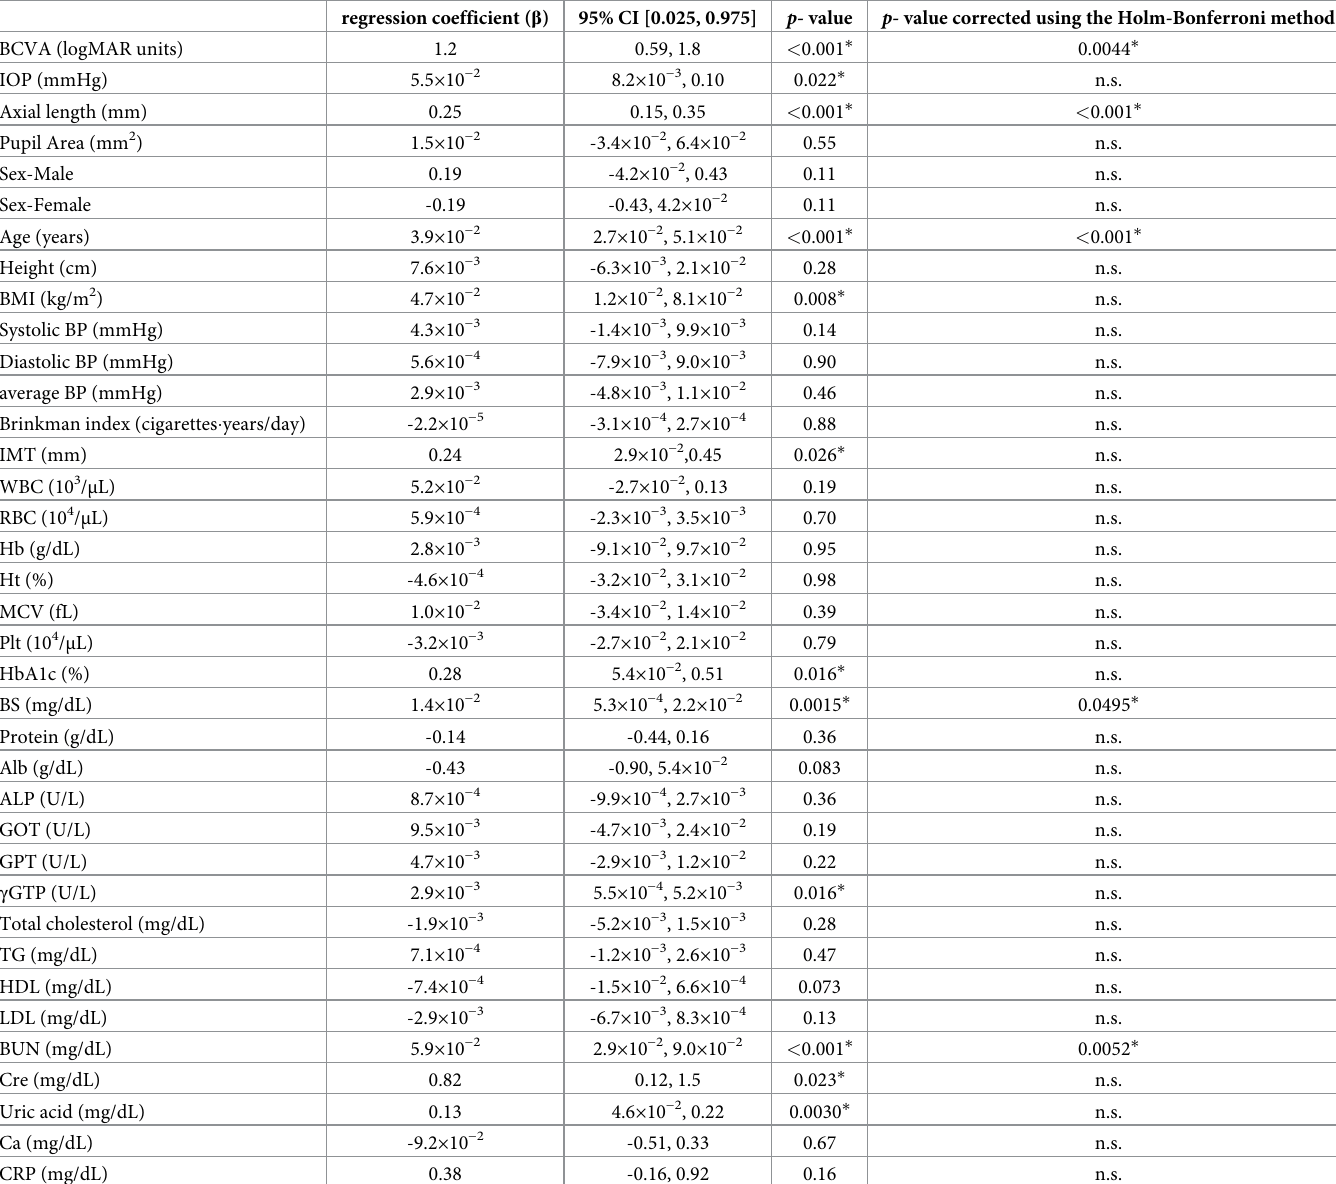
Table 2. Univariable linear mixed effects model regression analysis between implicit times and explanatory